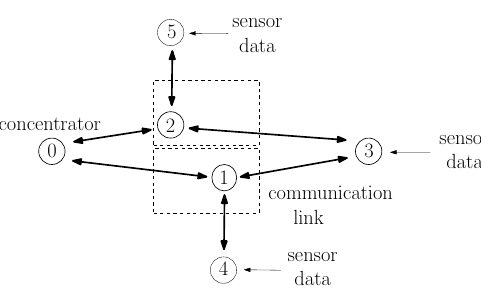
Figure 13. Topology where nodes 1, 2, 4, and 5 are randomly located.